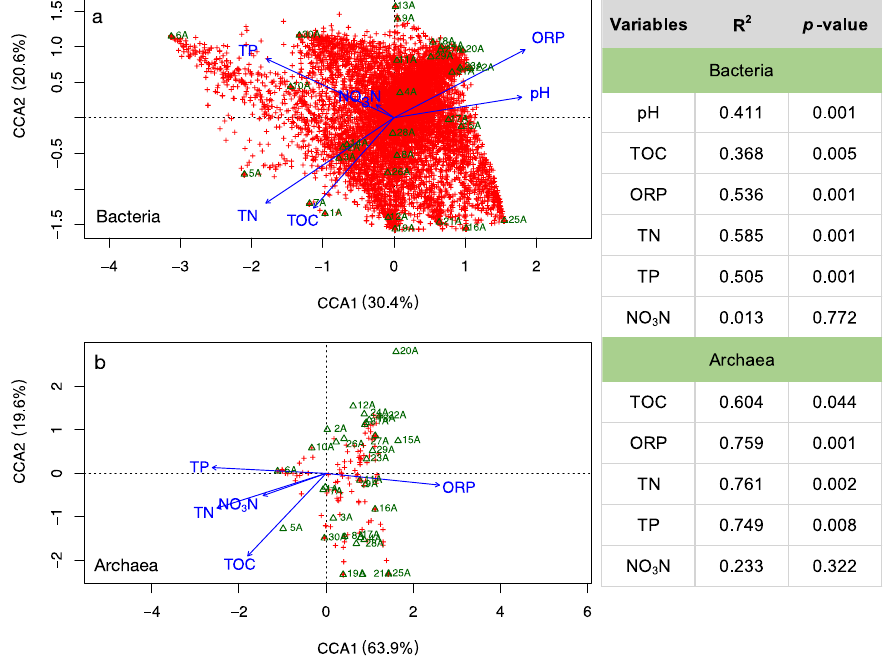
Figure 6. Canonical correspondence analysis of microbial community (bacteria ( a ) and archaea ( b )) and environmental variables in sediment. The red cross represents OTUs, while green triangle represents sampling sites.